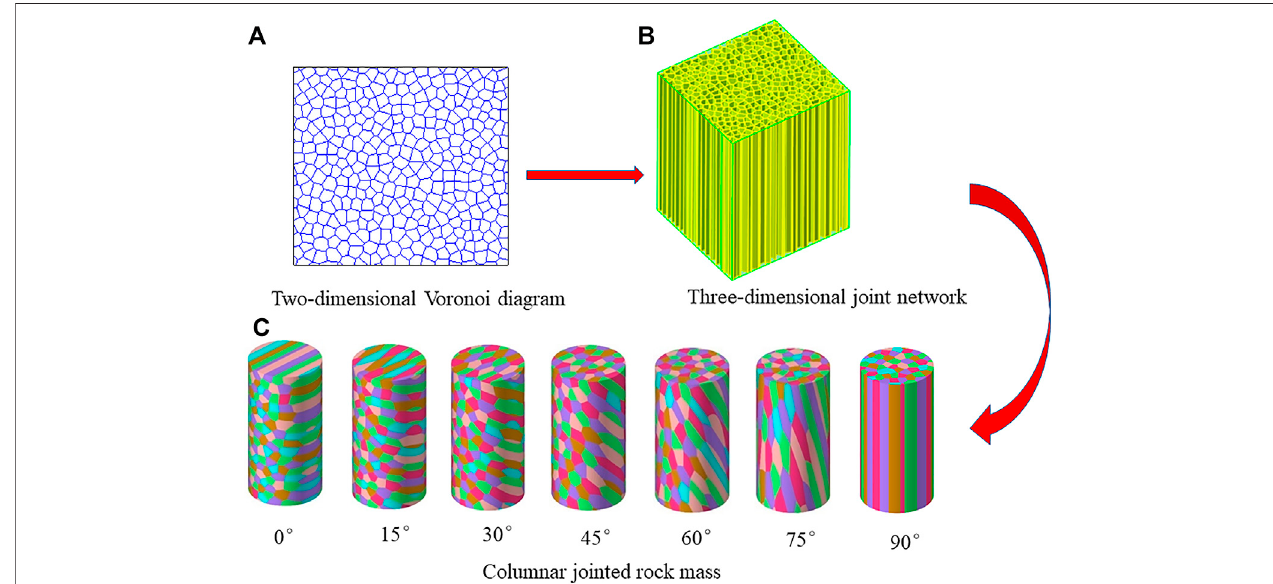
FIGURE1| Numerical model of columnar jointed rock mass.Atwo-dimensional Voronoi diagram with column section similar totheactual statistical law inthe fi eld isgeneratedbyusingimprovedVoronoiiterativealgorithm,shownin A .Thethree-dimensionaljointnetworkisthengeneratedbystretchingthetwo-dimensionaldiagram toacertainheight,shownin B .Amoredetaileddescriptionofthemethodandgeneratedmodelisshownintheliteratureof[19].AccordingtotheInternationalSocietyfor Rock Mechanics (ISRM), the numerical model of columnar jointed rock mass is cut to be circular cylinders with a height of 100 mm and a diameter of 50 mm at different column joint angles, shown in C